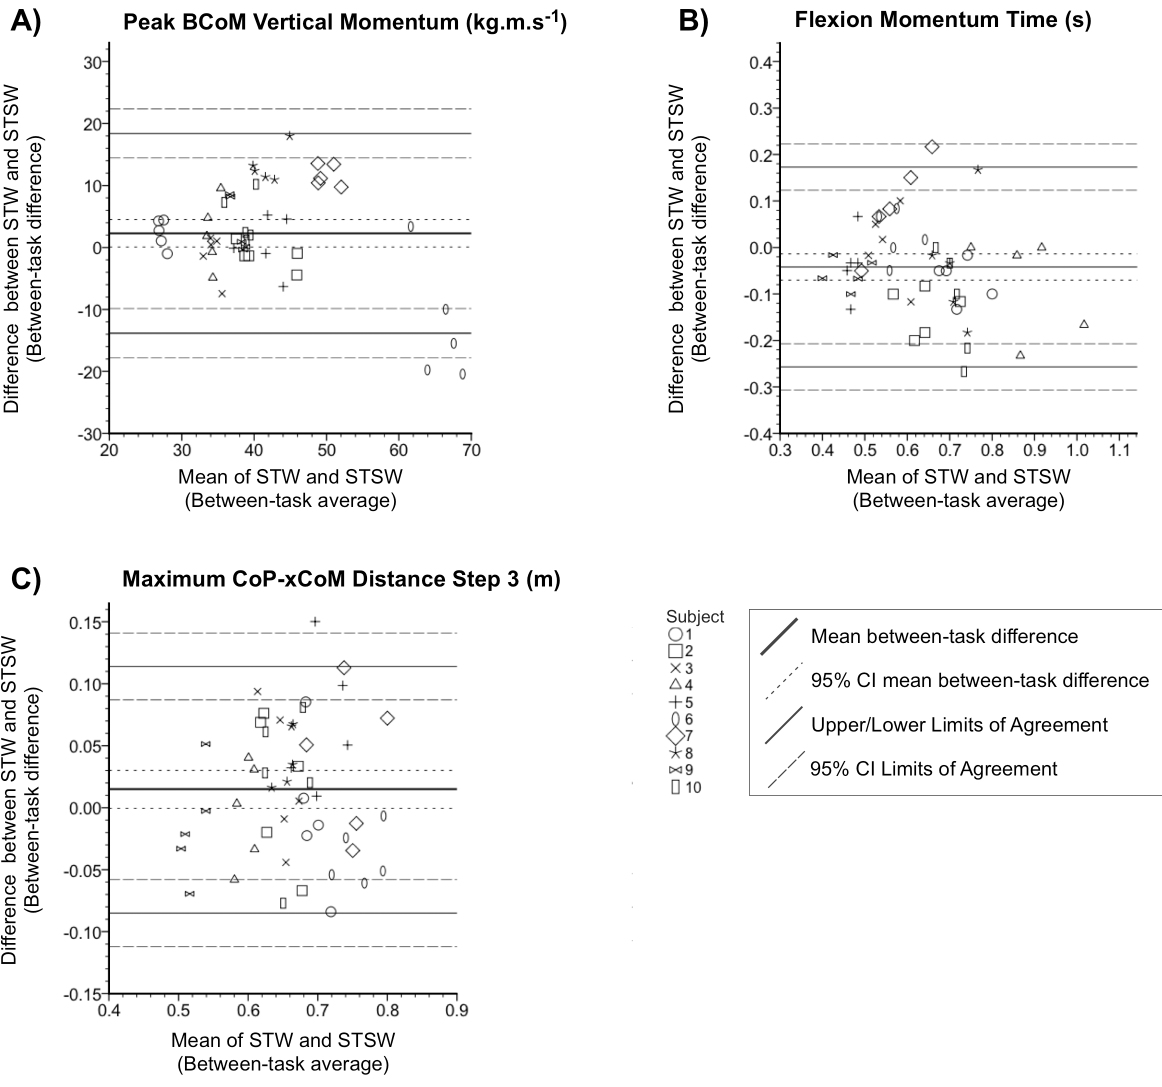
Fig 3. Bland and Altman plots. The differences (vertical axes) versus averages (horizontal axes) of STW and STSW for the three consistent movement parameters are shown; A) BCoM Vertical Momentum; B) Flexion-momentum time; C) Max CoP-xCoM Distance at Step3. Solid thick lines represent the mean between-task difference; short dashed lines represent the 95% confidence interval (CI) of the mean between-task difference. Lighter solid lines represent the limits of agreement (LOA), long dashed lines represent their 95% CIs.